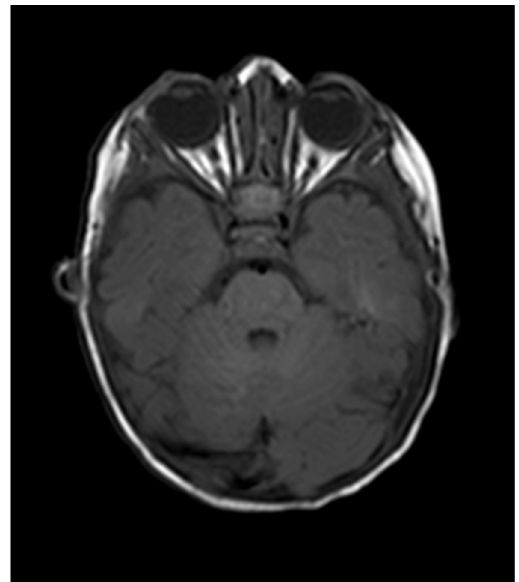
Figure 3. Four months after commencement of treatment. Complete resolution of proptosis. Skin hemangioma flat and pale.